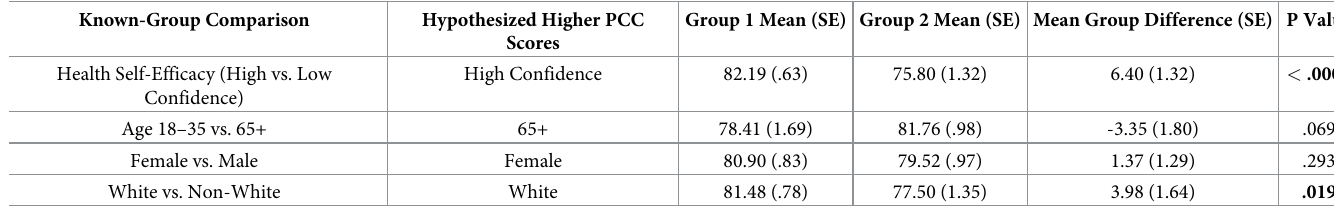
Table 4. Known-group comparisons, weighted means, standard errors, mean group differences and probabilities for PCC scale scores (Significant differences, alpha = .05, bolded). Known-Group